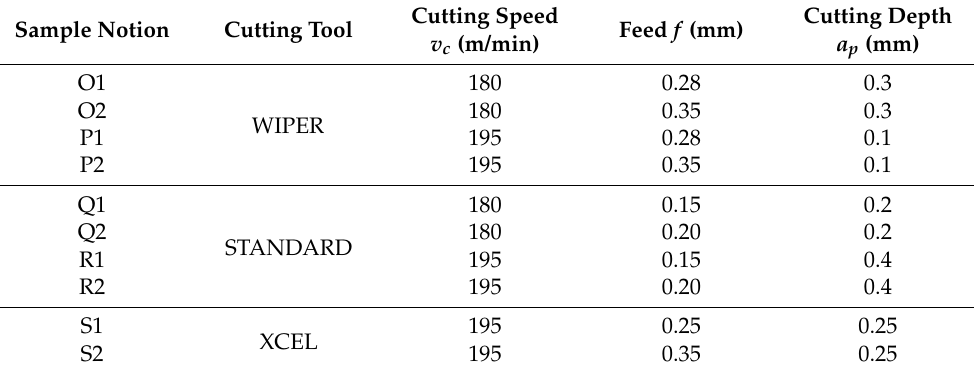
Table 1. Machining parameters used in the experiments for the respective samples. Sample Notion